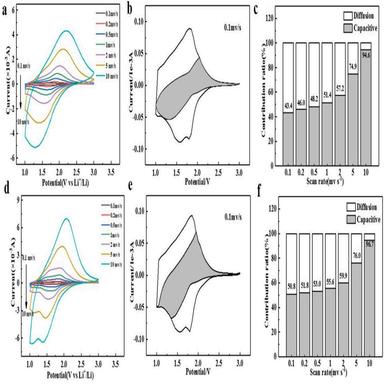
CV curves of (a) Nb2O5 and (d) Nb2O5-x at the different scans, Separation of the capacitive and diffusion currents at the scan rate of 0.1 mV s − 1 of (b) Nb2O5 and (e) Nb2O5-x, The contribution ratio of capacitive capacities of (c) Nb2O5 and (f) Nb2O5-x at 0.1–10 mV s − 1 .